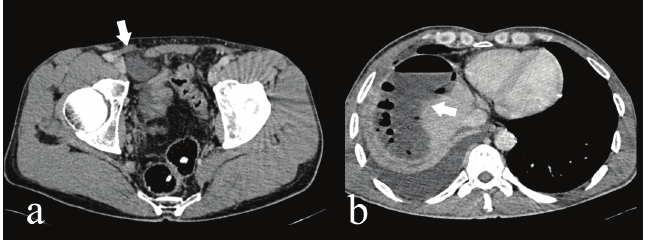
Figure 4 - Abscess formation (arrow) on pre-interventional CT (a) and the progression in abscess volume with previously unknown cecal tumor (arrow) on post-interventional CT (b) 7 days after percutaneous drainage in 82-year-old man with perforated appendicitis.